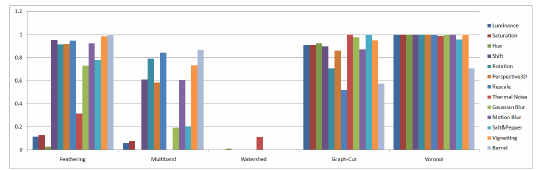
Figure 10. Mosaicing - Distortion PSNR MSE Response Normalized